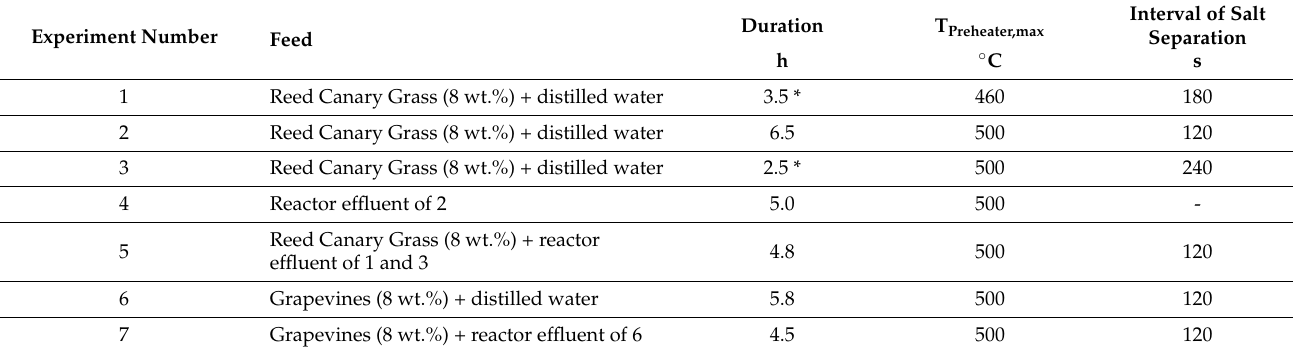
Table 2. Experimental Conditions of SCWG